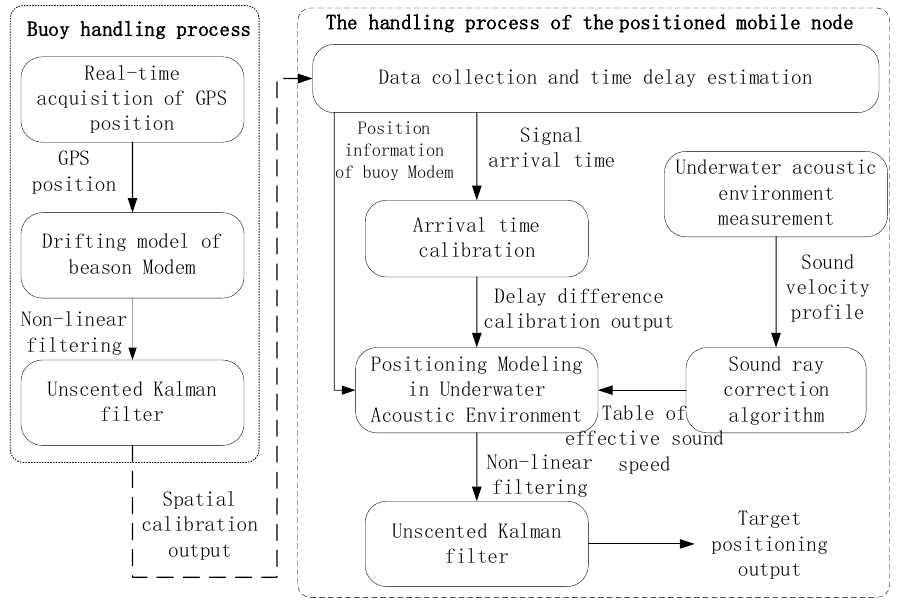
Figure 2. Working principle of the positioning system.